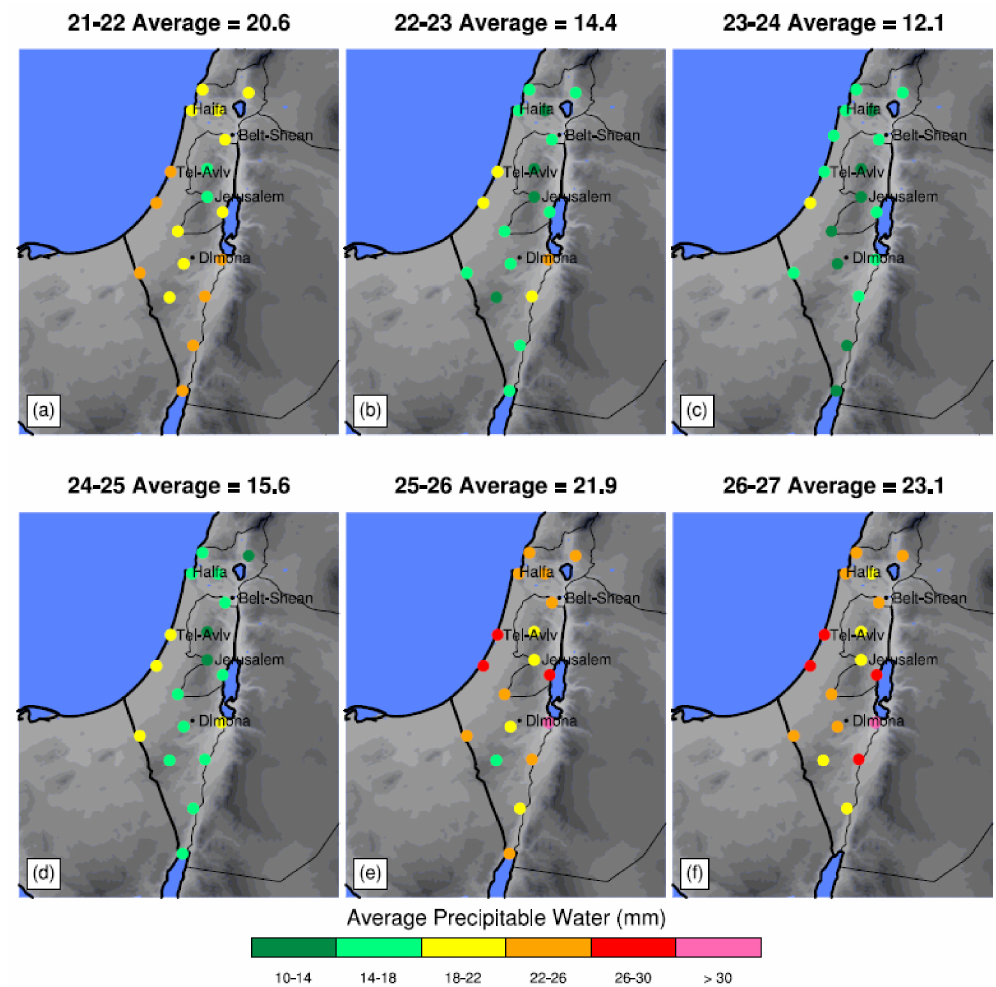
Figure 6. Same as Figure 4, but for daily averaged derived precipitable water from observations of satellite GPS data from ( a ) UTC 21 April to ( f ) 27 April